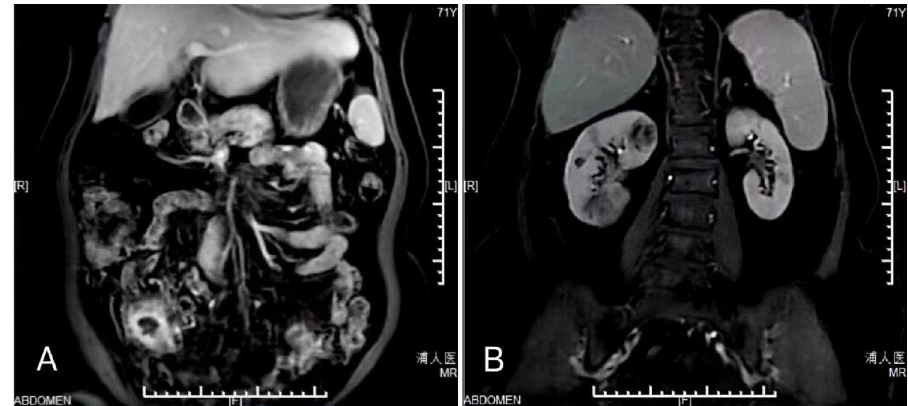
Fig. 1 Magnetic resonance imaging show that the local small intestinal wall is irregularly thickened and intensifies in the right lower abdomen (A) , with multiple hypersignal intensities observed in the right kidney